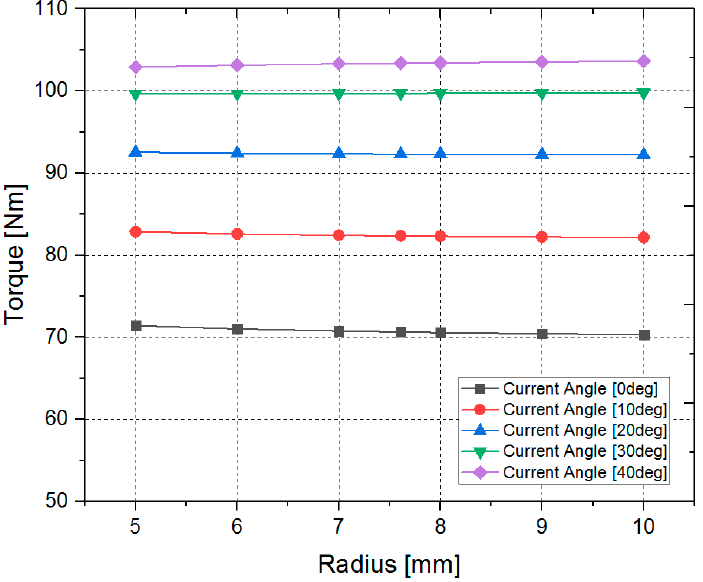
Figure 7. Comparative analysis of torque according to notch radius.